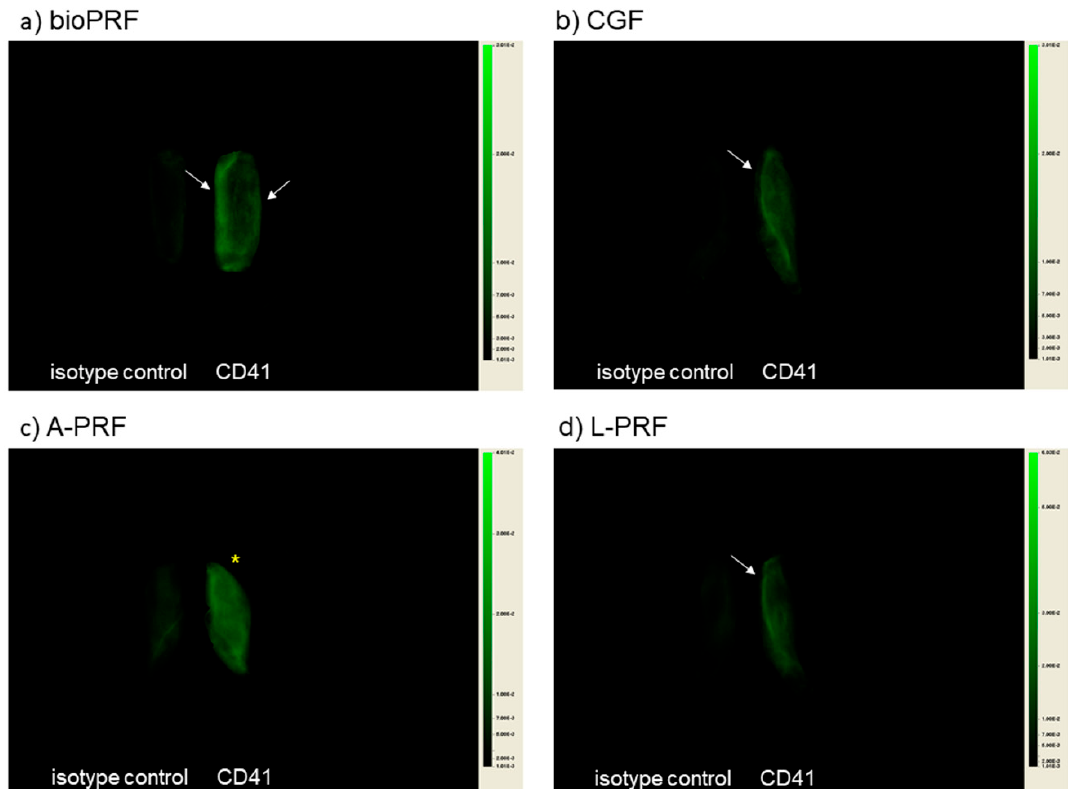
Figure 1. NIR images of compressed half PRF matrices: ( a ) bio-PRF (horizontal, fast spin); ( b ) Concentrated growth factors (CGF) (fixed angle, fast programmed spin); ( c ) A-PRF (fixed angle, slow spin); ( d ) L-PRF (fixed angle, fast spin). White arrows represent platelet localization. An asterisk denotes homogeneous platelet distribution.